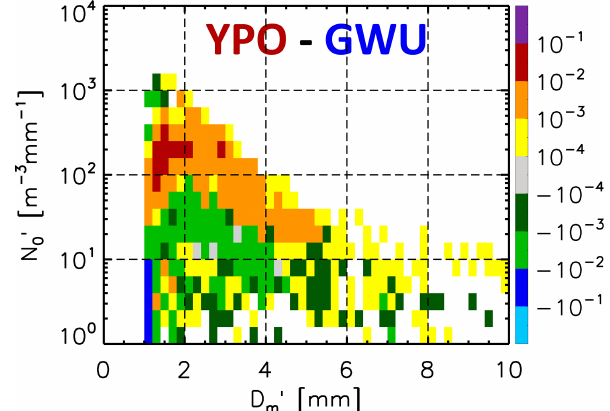
Figure 6. Difference in normalized frequency of N (cid:48) YPO and GWU sites. A warm (cold) color indicates that YPO (GWU) has more